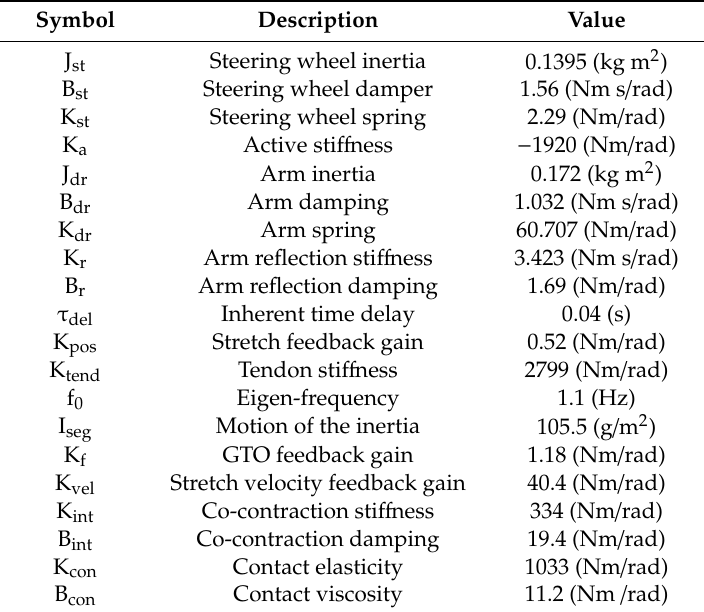
Table 1. Parameters of driver neuromuscular (NMS)